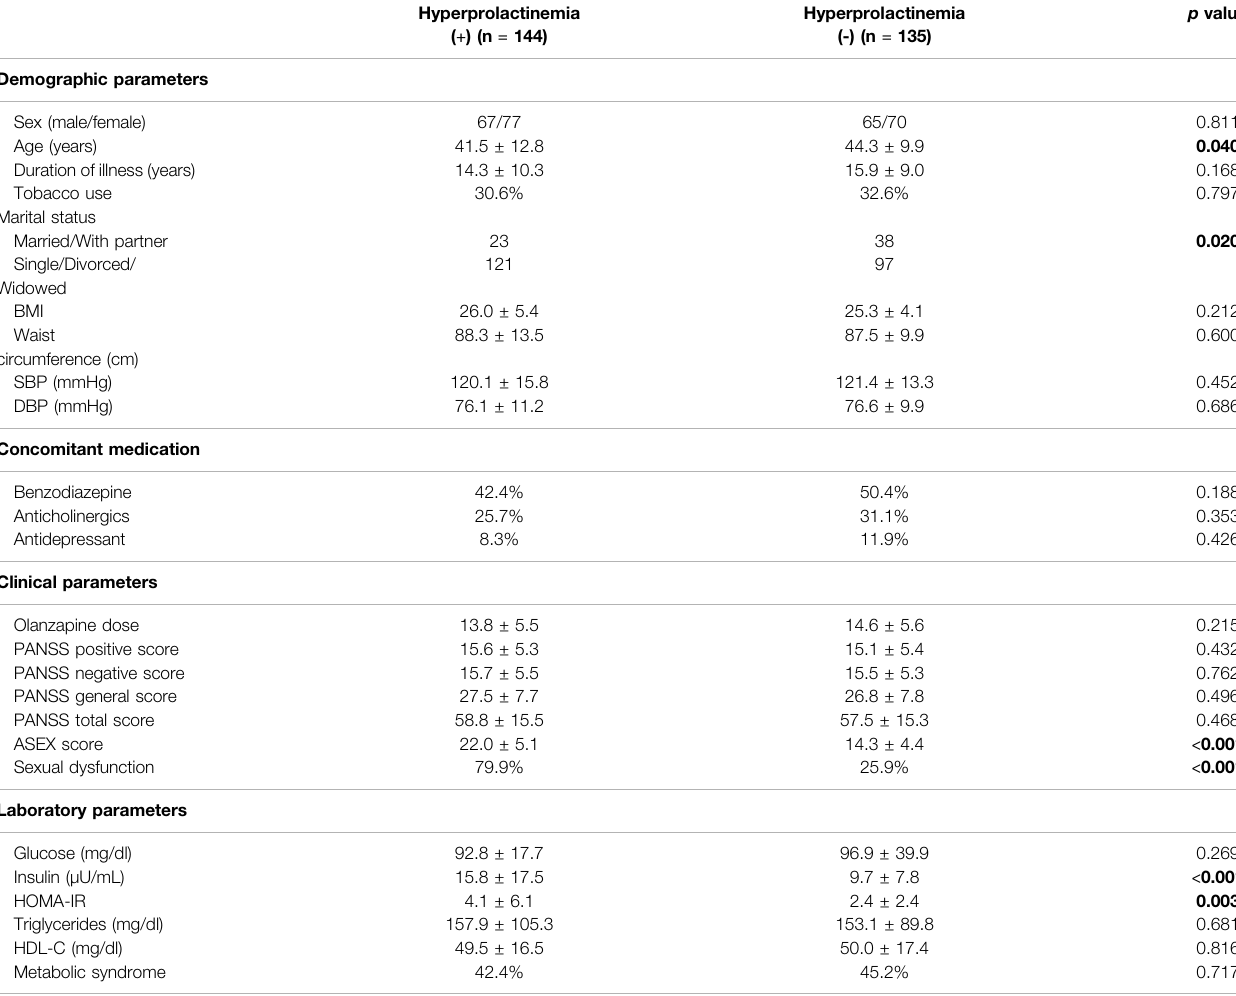
TABLE 1 | Demographic, clinical and laboratory characteristics of study subjects by hyperprolactinemia.